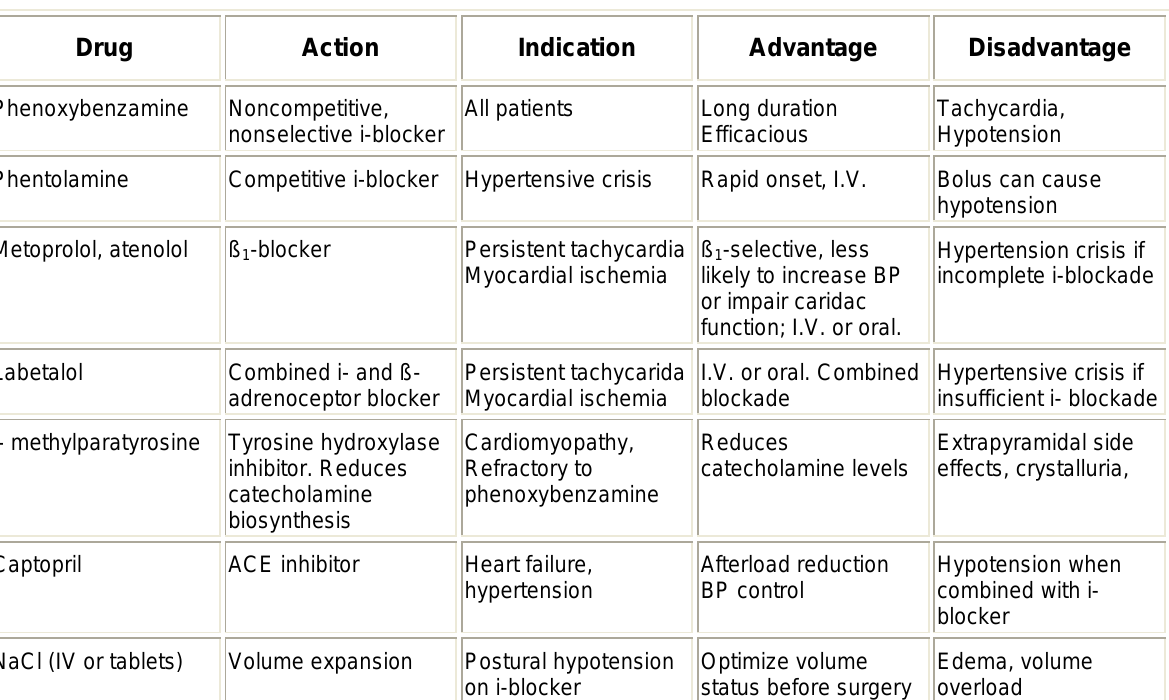
Drug Treatment for